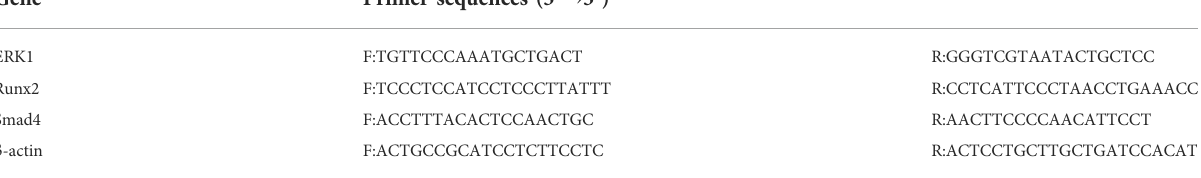
TABLE 1 Sequences of primers used for RT – PCR.